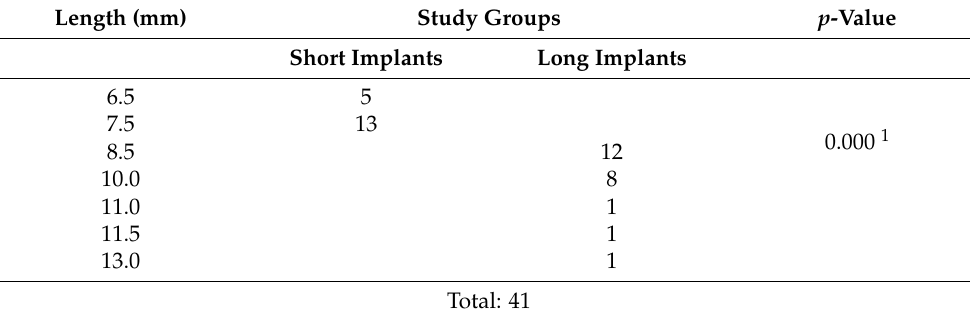
Table 2. Length of the short and long